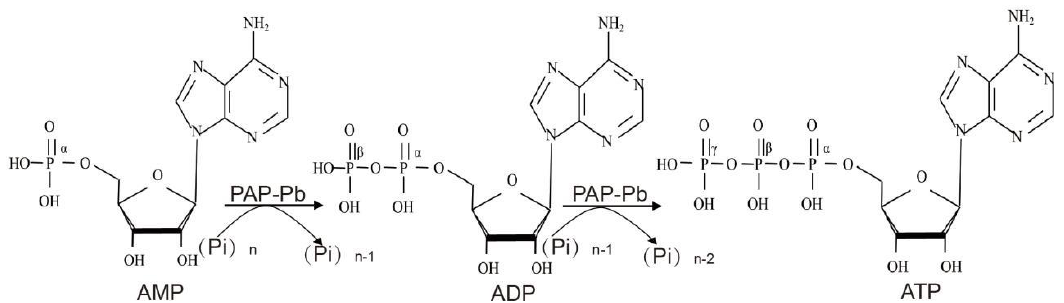
Figure 1. Schematic presentation of polyphosphate-based ATP regeneration from AMP or ADP catalyzed by phosphotransferase.